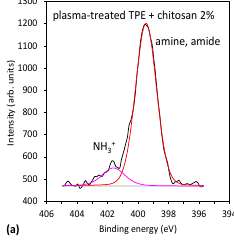
Figure 9. XPS nitrogen peaks of two-step plasma-treated catheters with chitosan coating (two layers): ( a ) TPE with 2% chitosan coating, ( b ) TPE with 2.5% chitosan coating, ( c ) PVC with 2% chitosan coating and ( d ) PVC with 2.5% chitosan coating.